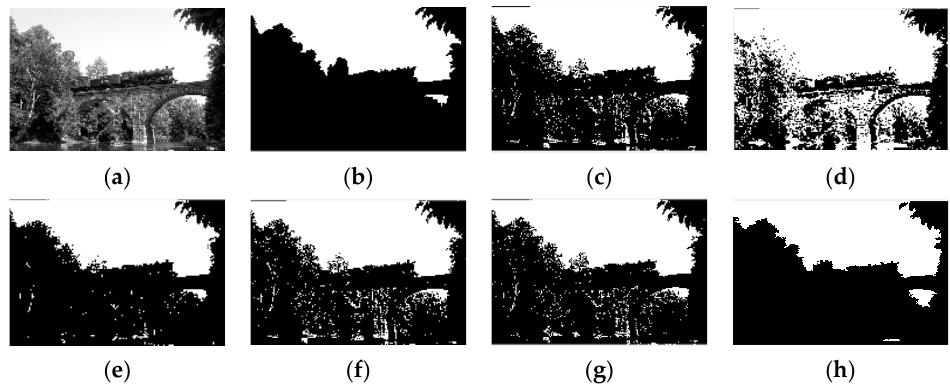
Figure 16. #351093 and its segmentations: ( a ) #351093, ( b ) ground-truth, ( c ) Otus, ( d ) MRCUT, ( e ) EITMIS, ( f ) NSWCC, ( g ) IT2FSWCC, ( h ) FSEFTISRI. ( e ) EITMIS, ( f ) NSWCC, ( g ) IT2FSWCC, ( h ) FSEFTISRI.